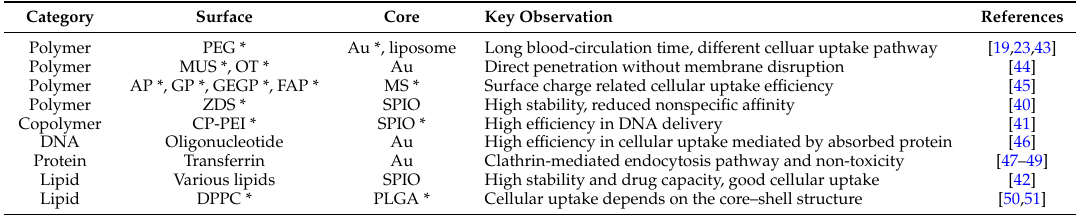
Table 1. Examples of various nanoparticle surface